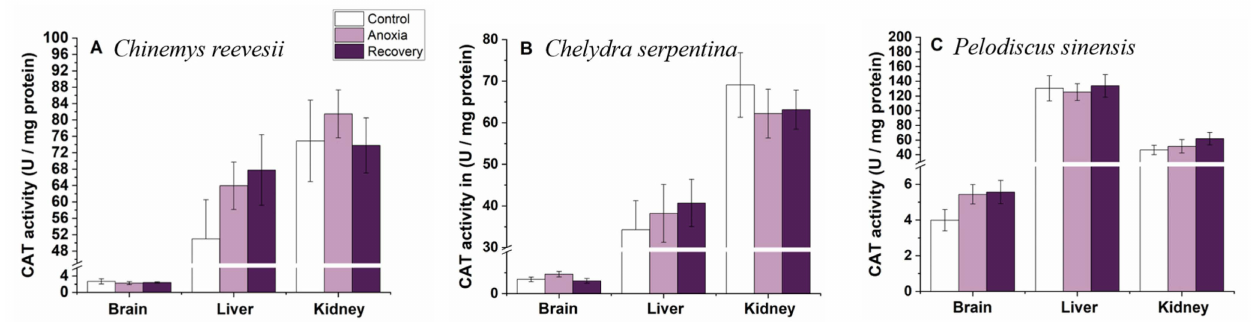
Figure 8. Changes of anoxia stress on CAT activity in tissues of C. reevesii ( A ), C. serpentina ( B ) and P. sinensis ( C ). Data are presented as mean ± SE. N = 10. Data with no common lowercase letters on the bar indicate significant differences between different groups ( p <